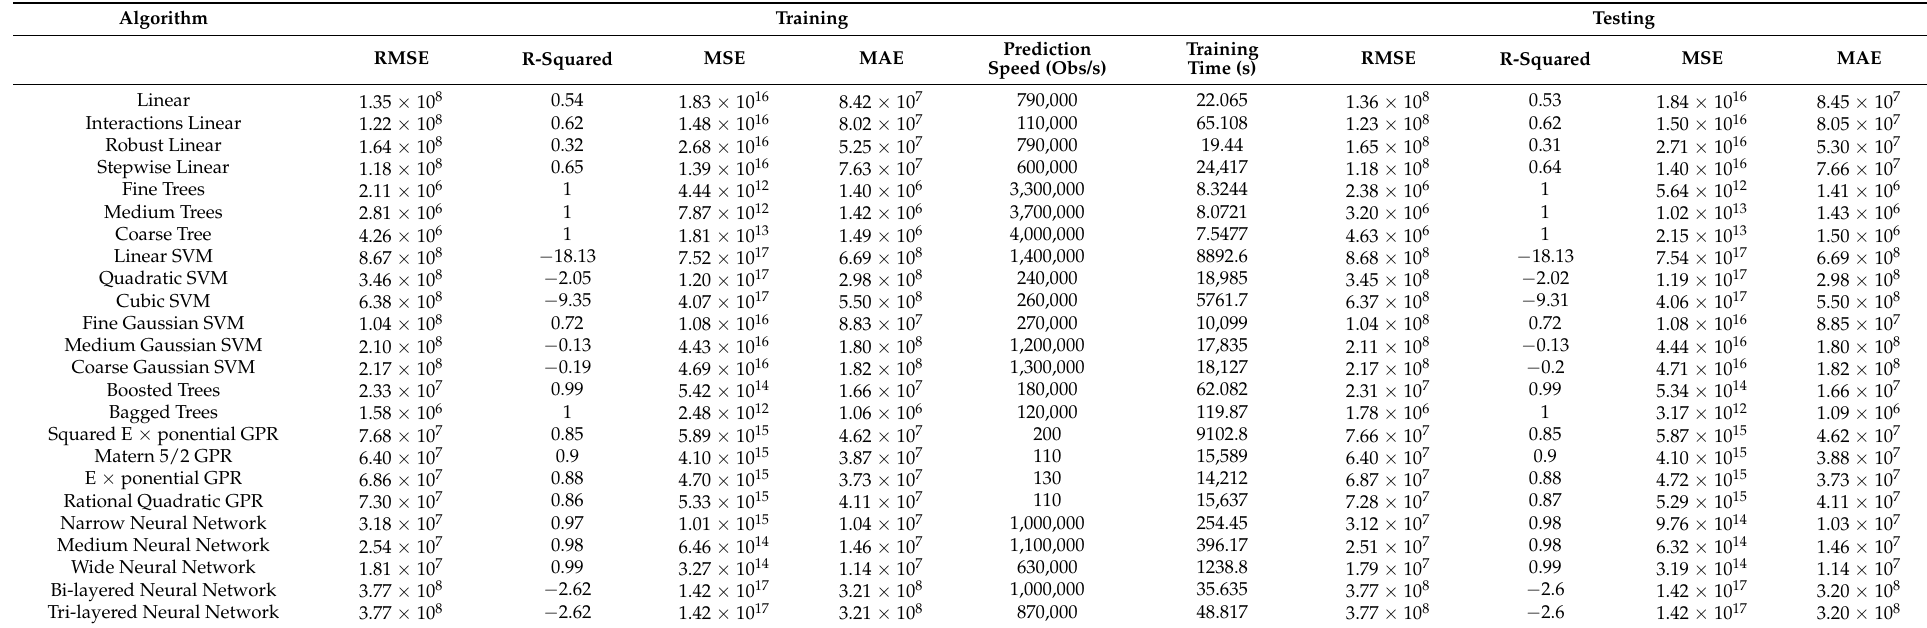
Table 3. Performance evaluation of machine learning algorithm for energy prediction on SEIL